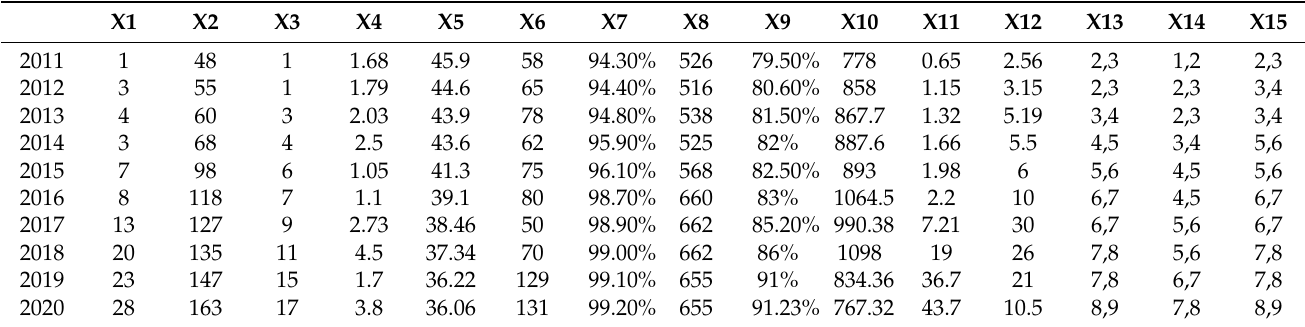
Table 5. Decision